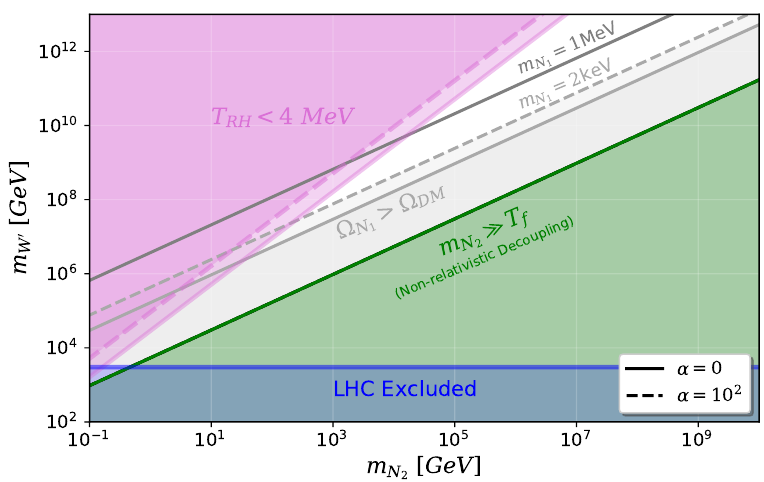
Figure 4 . Viable parameter space in the plane ( m W 0 , m N ) . The correct dark matter relic density 2 is achieved along the light-grey ( m N = 2 keV) and grey lines ( m N = 1 MeV). The continuous lines 1 1 are for α = 0 and the dashed lines, for α = 10 2 . The pink and blue regions are excluded respectively by BBN ( T RH < 4 MeV ) and LHC ( m W 0 < 3 GeV ). In the green region, the necessary requirement of ultra-relativistic decoupling of N 2 does not